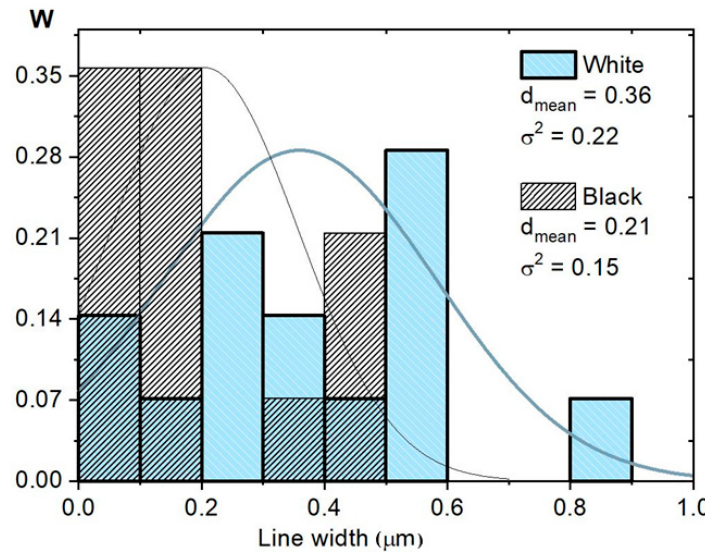
Figure 5. The width distribution of the lamellar in the Ti-Al-Y sample. Al-rich bands are characterized by a large width range from 0 to 0.9 µm. Bands with a width of 0.5–0.6 µm make up the majority of the surface of the structure (the share is 0.25). There is an insignificant number (0.07 fraction) of bands with a width of 0.8–0.9 µm. In the sample volume, the structure at the surface was represented by an oxide layer, a Ti 2 Al phase, and randomly arranged particles, containing yttrium. The analysis of the quantitative composition distribution of aluminum, titanium, and yttrium in the sample showed that the lamellar structure was formed in the entire sample area and was represented by Ti 3 Al, Ti 2 Al, and TiAl phases (Figure 6a,b). Bands enriched in titanium (Ti- rich) and aluminum (Al-rich) alternated (Figure 6a–f). The EDS from the band section in the sample volume is presented in Figure 6 (spectrum 1–2). The aluminum content varied by the sample volume; Ti 3 Al and TiAl phases were sequentially formed. In the sample volume, the Ti-rich and Al-rich bands were more homogeneous in composition. The particles in the sample volume, located close to the near-surface layer, are compounds of yttrium and aluminum (Y 2 Al, Y 5 Al 3 , YAl 3 and YAl). The particles’ composition is represented by phases of the Al-Y system, covered with an oxide layer. According to the spectral analysis (Figure 6, spectra (1–6)), an oxide layer is formed, represented by aluminum, titanium, and yttrium oxides (Table 1). Titanium can oxidize in air, so the titanium oxide formation is probably related to the fact that the sample was in contact with air. The layer formation occurs at the boundaries of Ti 3 Al and TiAl. The concentration changes of the elements (Ti, Al, Y, and O) are shown in Figure 6g. The work has shown that, when obtaining the TAY sample by the hydride technology, yttrium is distributed along the particle boundaries. A detailed study by the TEM method has shown that yttrium is present both in the form of individual particles and in combination with oxygen, aluminum, and titanium. The interaction with the latter leads to the formation of a triple compound. During the experiment, the authors discovered that yttrium has a heterogeneous distribution and concentration in some small areas in the interdendritic regions [38], and the oxide scale, which contains the Y 2 O 3 phase, improves the high-temperature wear characteristics of Stellite 21, especially at tempera- tures above 500 °C.